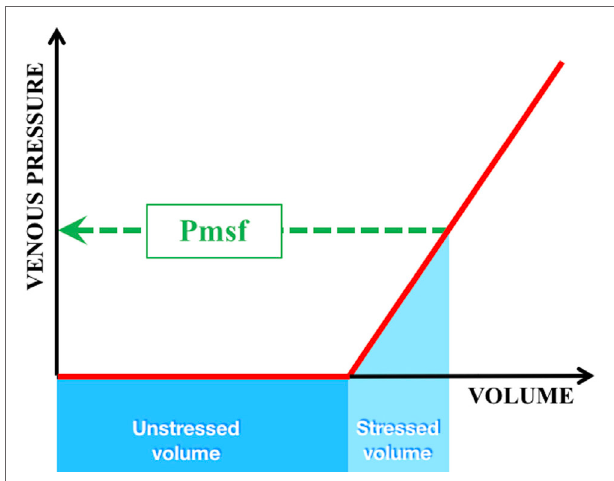
FigURe 4 | Intravascular volumes and pressure in the venous compartment. Green interrupted line = Pmsf mean systemic filling pressure; dark blue box = unstressed volume = that volume which is required to fill the vasculature without increase in transmural pressure; light blue box = stressed volume = any amount of volume added to the unstressed volume that leads to an increase in transmural